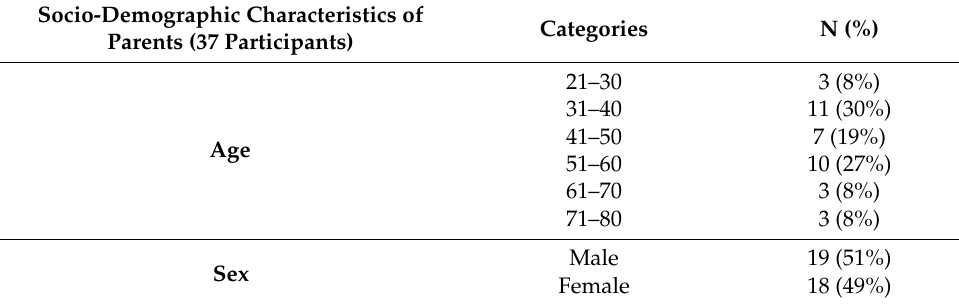
Table 1. Socio-demographic